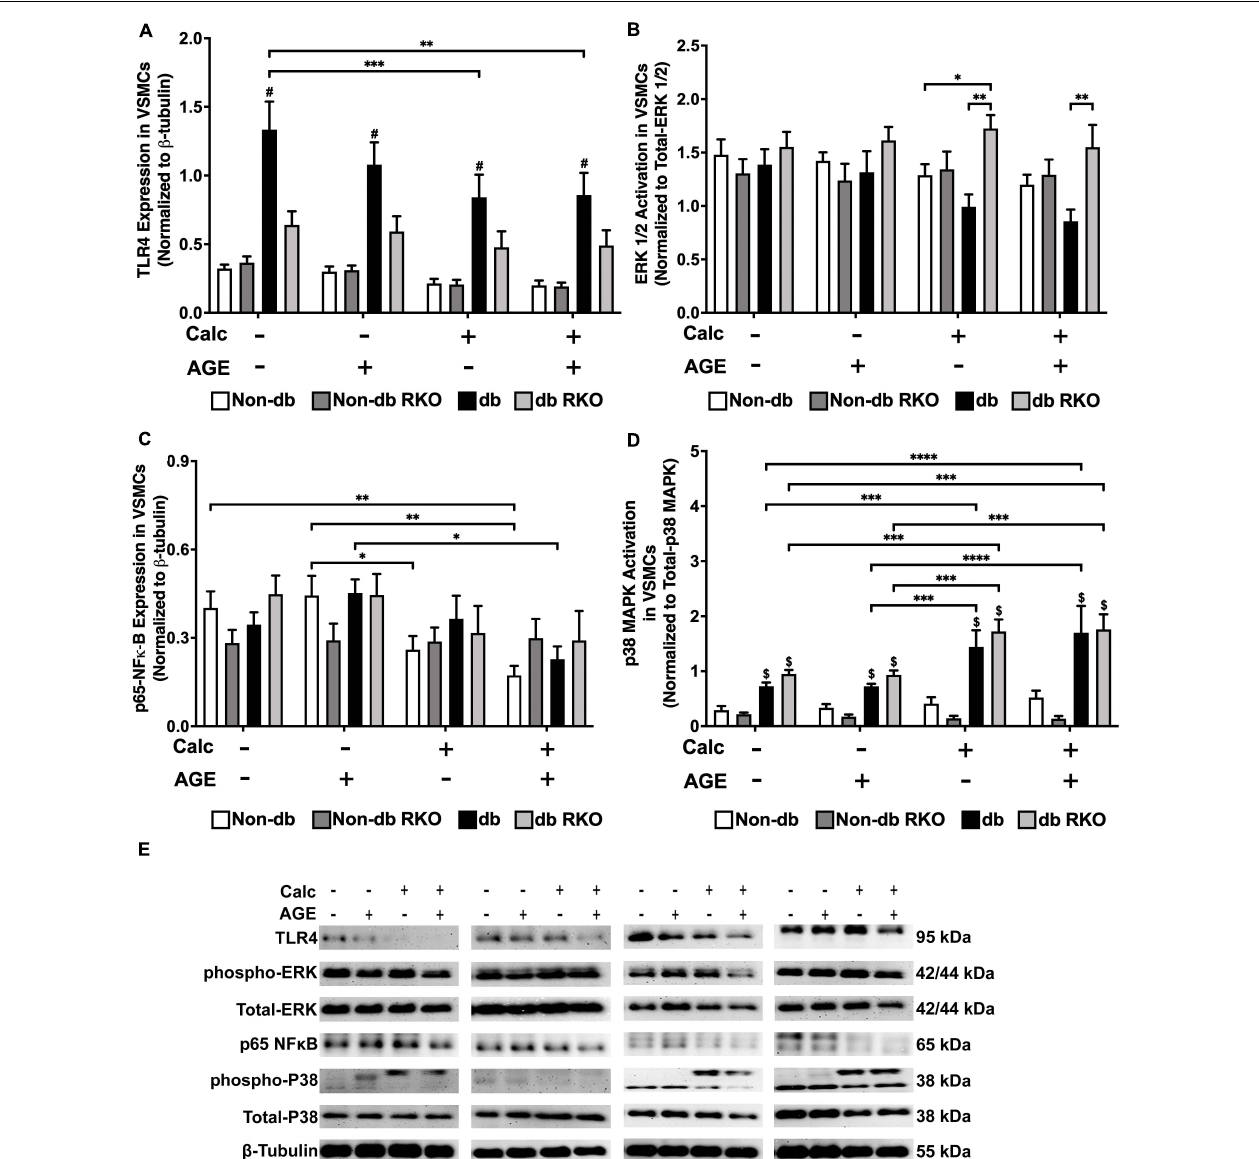
FIGURE 3 | Diabetic vascular smooth muscle cells utilize RAGE signaling through the phospho-p38 MAPK-RAGE axis. Protein expression of TLR4 (95 kDa; A ), activated ERK 1/2 (42/44 kDa; B ), phosphorylated-p65-NF- κ B (65 kDa; C ), and activated p38-MAPK (38 kDa; D ) was quantified. Non-diabetic, non-diabetic RKO, diabetic, and diabetic RKO primary VSMCs were isolated and treated with 3 mM P i with or without AGEs (0.5 mg/mL) for 7 days. Protein levels were normalized to β -tubulin (E) and graphed as mean ± SEM with n = 6–9 of independent replicates. Statistical analysis consisted of a two-way ANOVA and a Fisher’s LSD test post hoc ( $ p < 0.05 toward non-diabetic cell types in treatment group, * p < 0.05, ** p < 0.01, *** p < 0.001, **** p <